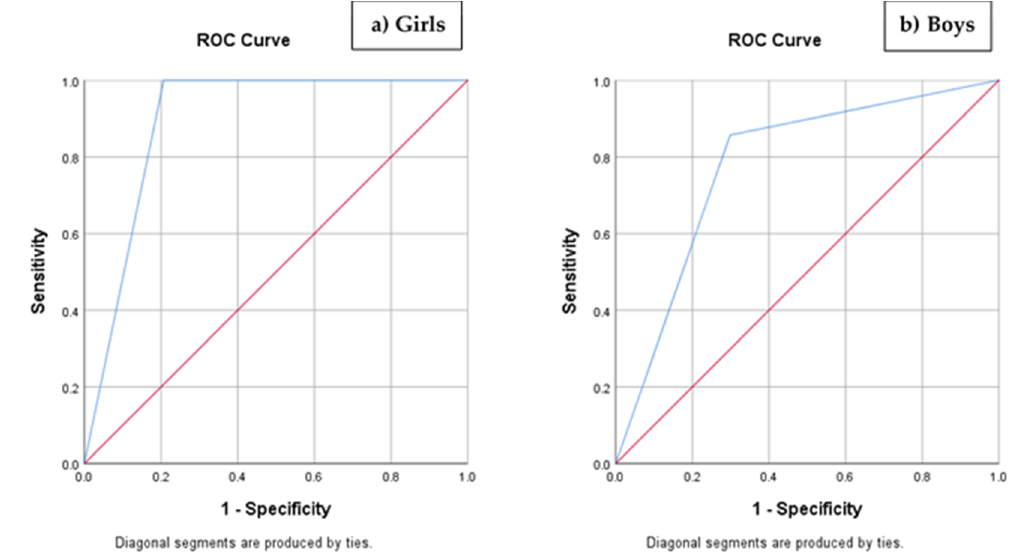
Figure 1. Performance of the proposed screening tool (RisObIn.Com) to identify girls ( a ) and boys ( b ) in the transition from pre-school to primary school that had overweight (including obesity) with WtHr > 0.5 while in primary school. The receiver operating characteristic (ROC) curves were calculated for the cutoff point value of zero. The area under the ROC curve was 0.897 (95%CI 0.825-0.968; p < 0.001) for girls; and the area under the ROC curve was 0.779 (95%CI 0.612-0.947; p = 0.016) for boys. CI: Confidence Interval; WtHr: Waist-to-Height Ratio.